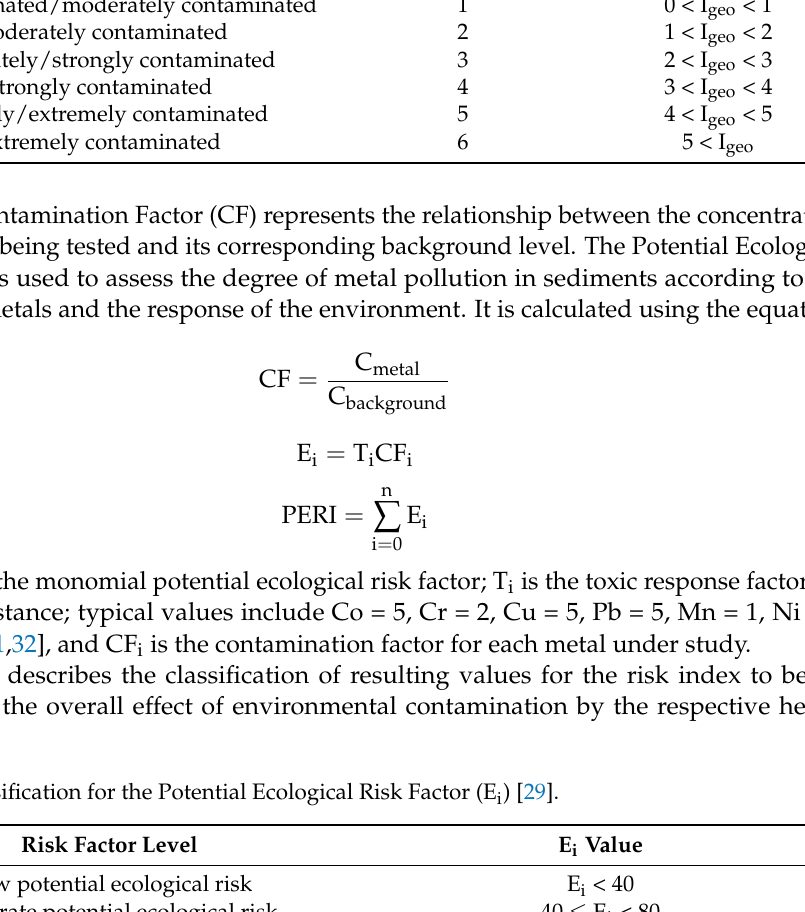
Table 3. Classification of geo-accumulation index (I geo ) [29]. Geo-Accumulation Index Level I geo Class Uncontaminated